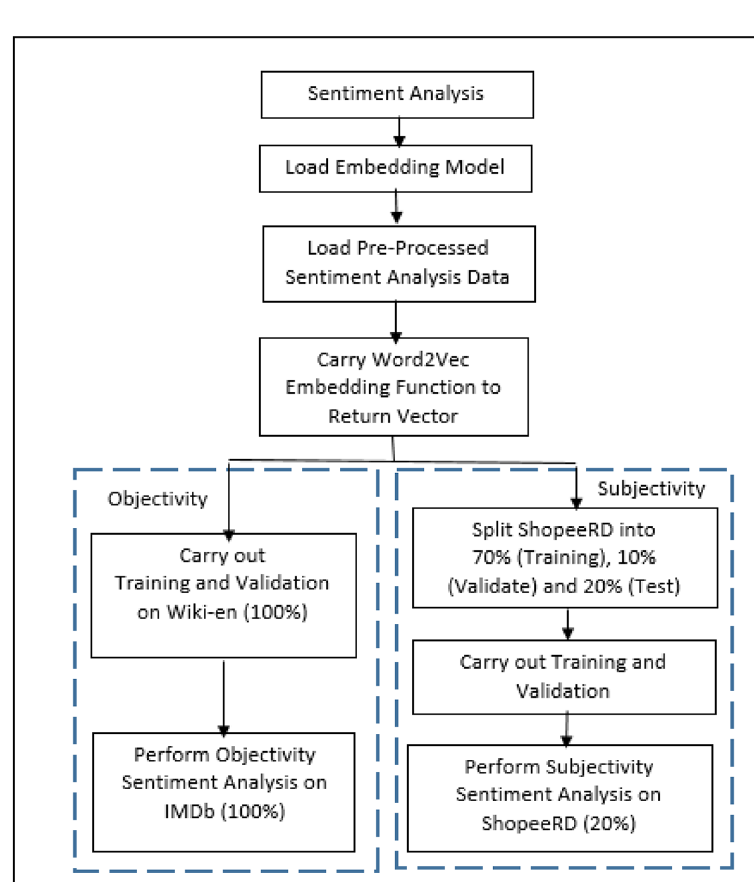
Figure 3. Sentiment analysis.